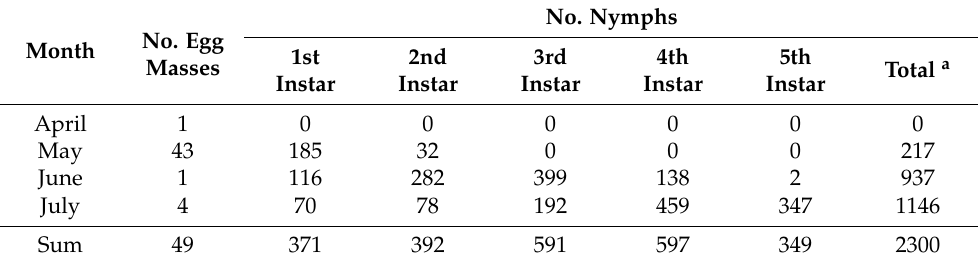
Table 4. Numbers of egg masses and nymphs of Pyrops candelaria recorded from April to July